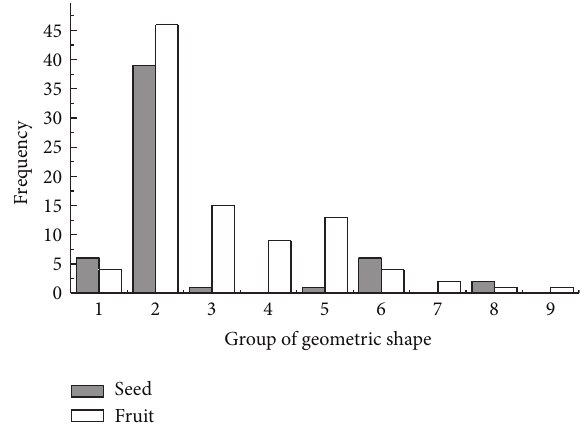
Figure 9: Frequency distribution of diaspore geometric shape. (1) Spheroideus, nearly-spheroideus; (2) elipsoid, broad-elipsoid, narrow-ellipsoid, ovoid, elongated-ovoid, obovoid, elongated- obovoid, subulate-ovoid, cylindrical-obovoid, spherical, spherical- ovoid; (3) lenticular, planular-ovoid, oblate-disc; (4) cylindrical, conical; (5) spindly, lanceolate, needle, Linearis; (6) reni; (7) arcuatus, curved; (8) trigonous, triqueter; (9) fan,